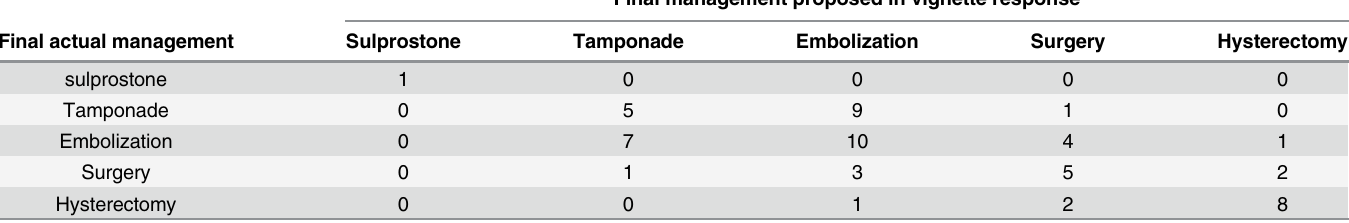
Table 2. Final agreement in cases managed by other obstetrician.